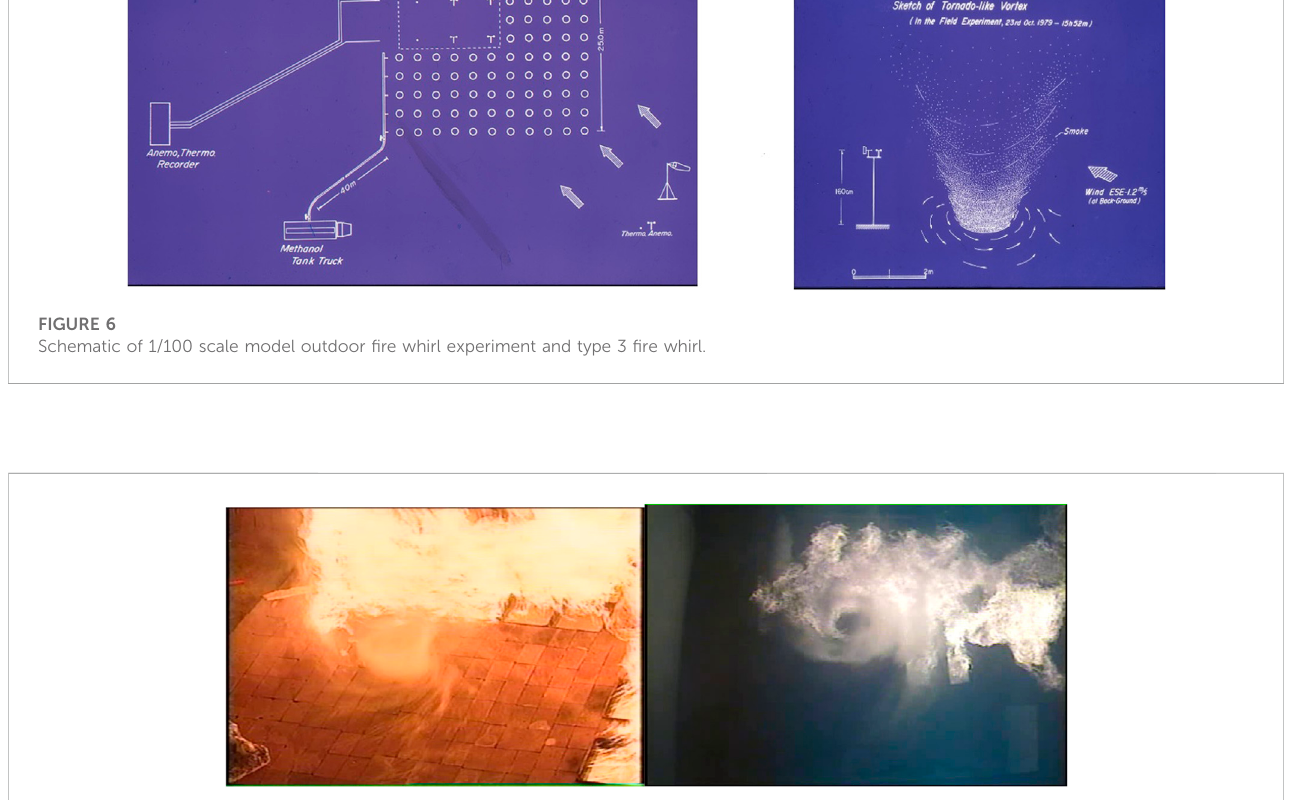
FIGURE 7 Aphotographofatype3 fi rewhirlisvisualizedbyrisingwatervaporfromthe fl oor.Left:sideviewandright:topview.Foraschematicofthe1/1,000scale model HAFW experiment, see Figure